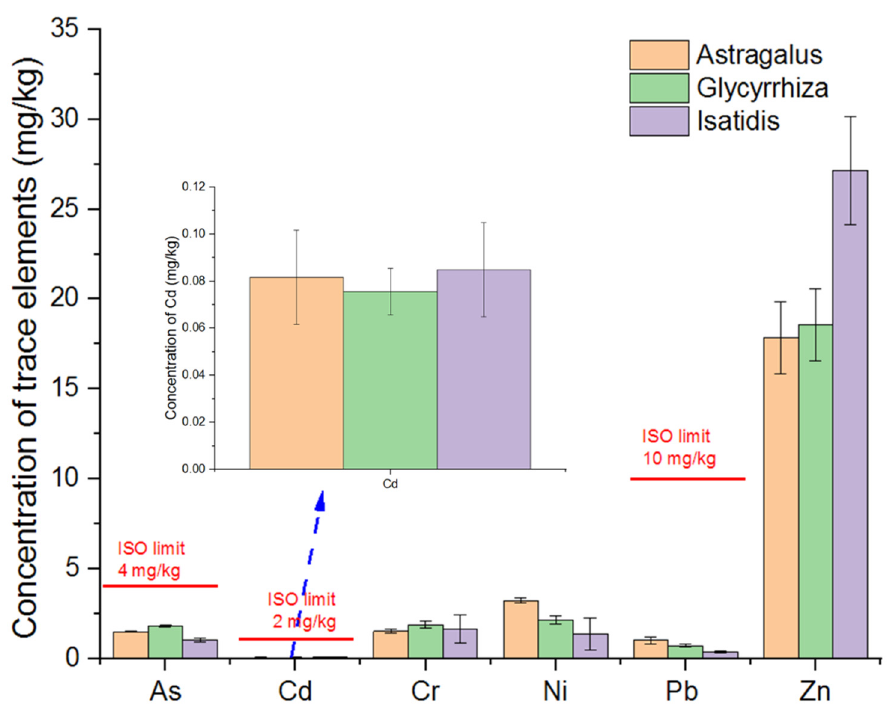
Figure 2. Total concentrations of trace elements in CHMs (mg/kg). Table 1. The standard for Chinese medicinal materials in terms of the total concentrations of trace elements (unit: mg/kg).